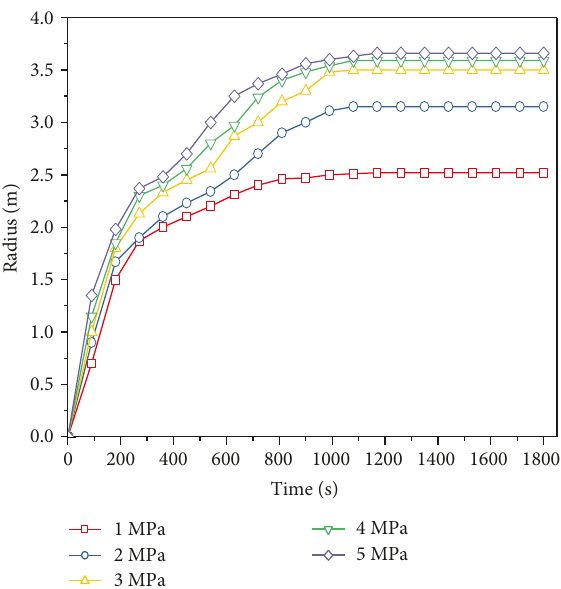
Figure 18: Slurry di ff usion radius under di ff erent grouting pressures (W :C